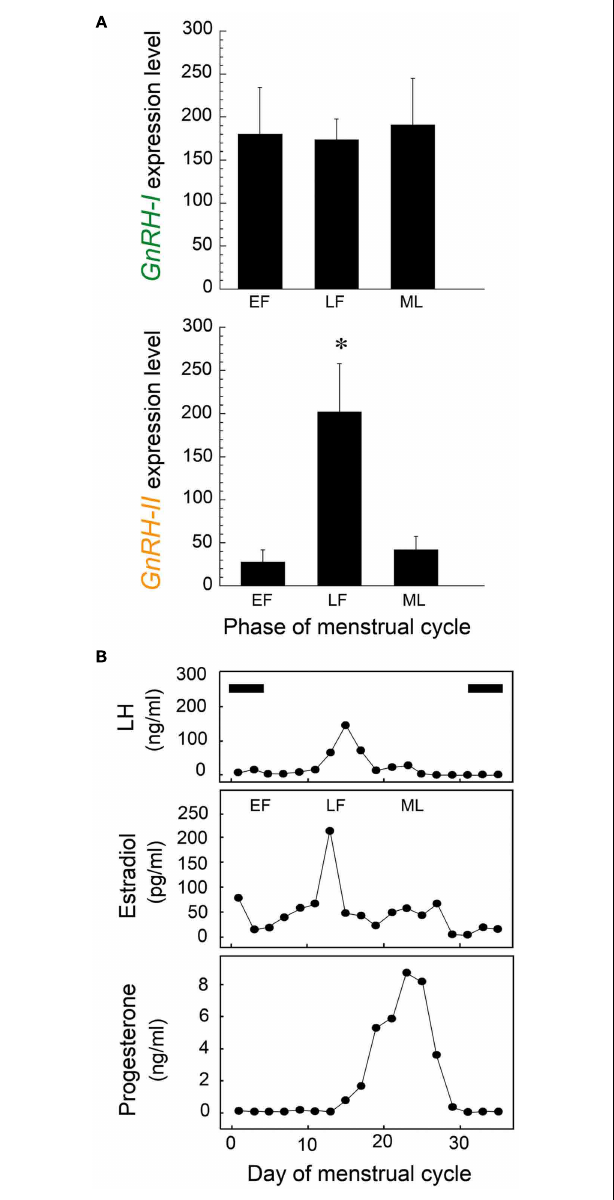
FIGURE 5 | (A) Mean expression of GnRH-I (upper panel) and GnRH-II (lower panel) mRNA levels in the rhesus monkey hypothalamus, as determined by Affymetrix GeneChip microarray analysis (HU133A plus 2.0; N = 3–4/group).The following three characteristic stages of the menstrual cycle were examined: EF, early follicular; LF, late follicular, ML, mid-luteal. The level of GnRH-I gene expression was similar across the menstrual cycle, whereas the level of GnRH-II gene expression showed a significant mid-cycle increase (* P < 0.05). (B) Serum reproductive hormone profiles from a representative female rhesus macaque across a complete menstrual cycle. Note the temporal relationship between the mid-cycle preovulatory LH surge and the elevated serum estradiol levels of the LF phase. Periods of menstruation are indicated by black horizontal bars.Together the data suggest that estradiol-mediated activation of GnRH-II neurons may play a key role in triggering ovulation, whereas GnRH-I neurons are more likely to play a role in modulating tonic LH release and in follicular maturation. (Adapted from Urbanski et al.,